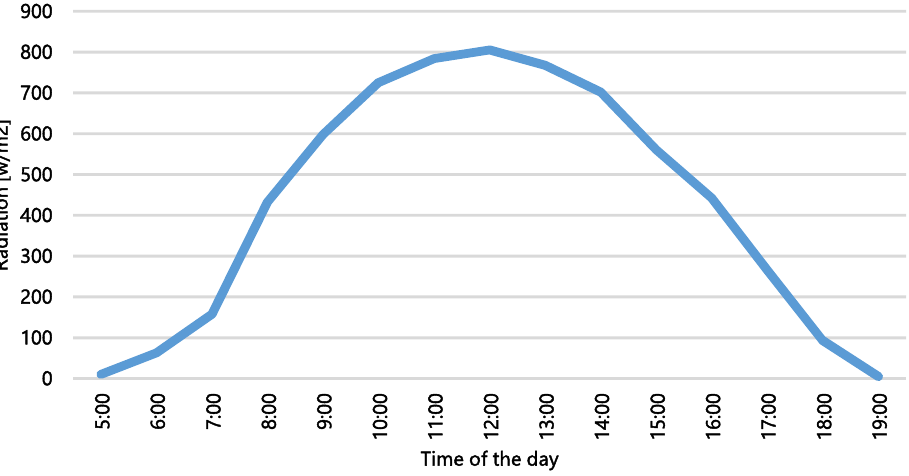
Figure 2. The used radiation data taken from National Renewable Energy Laboratory (NREL).